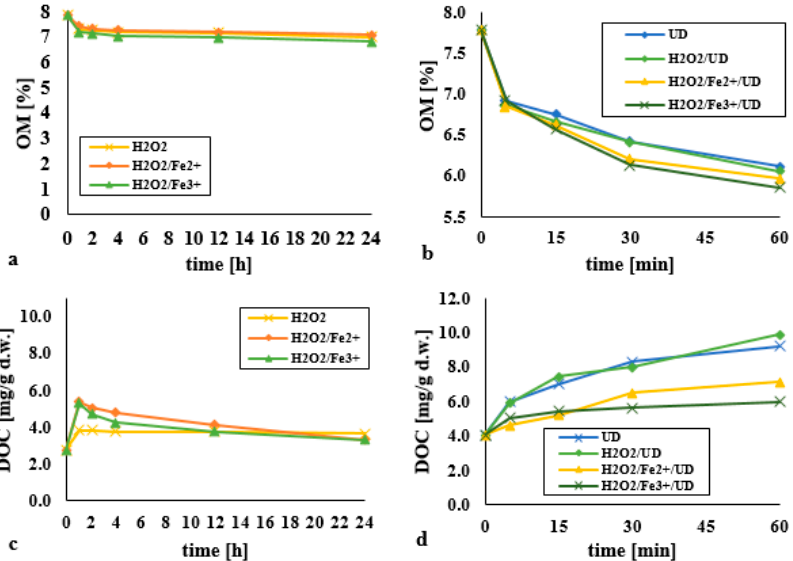
Figure 10. The impact on ( a ) OM exerted by the use of H 2 O 2 (pH = 3, DEHP:H 2 O 2 1:1), the Fenton process (pH = 3, molar ratio DEHP:H 2 O 2 :Fe 2+ 1:1:1), the modified Fenton process (pH = 3, DEHP:H 2 O 2 :Fe 3+ 1:1:1) ( b ) OM exerted by the use of UD (pH = 10, acoustic wave intensity-3.97 W/cm 2 ), H 2 O 2 /UD (pH = 10, DEHP:H 2 O 2 1:1, 3.97 W/cm 2 ), H 2 O 2 /Fe 2+ /UD (pH = 10, molar ratio DEHP:H 2 O 2 :Fe 2+ 1:1:1, 3.97 W/cm 2 ), H 2 O 2 /Fe 3+ /UD (pH = 10, molar ratio DEHP:H 2 O 2 :Fe 3+ 1:1:1, 3.97 W/cm 2 ); ( c ) DOC exerted by the types of single process ( d ) DOC exerted by the type of process